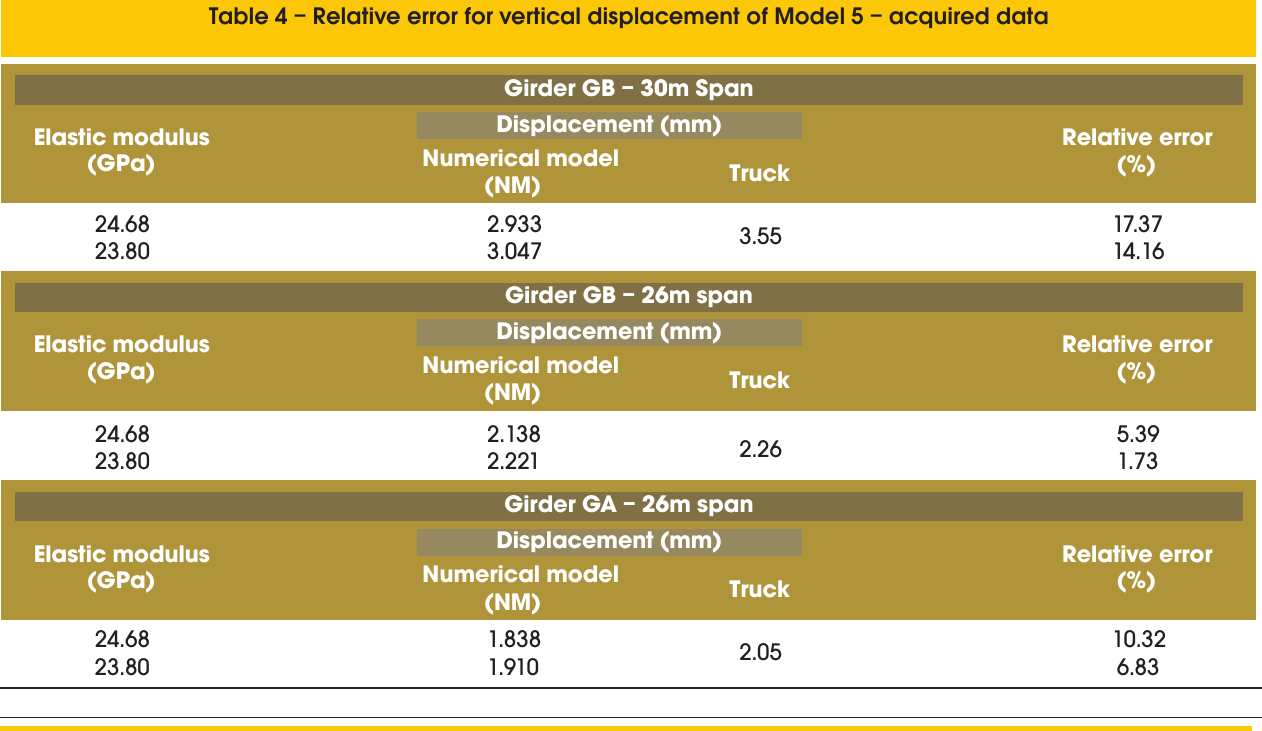
Table 4 – Relative error for vertical displacement of Model 5 – acquired data